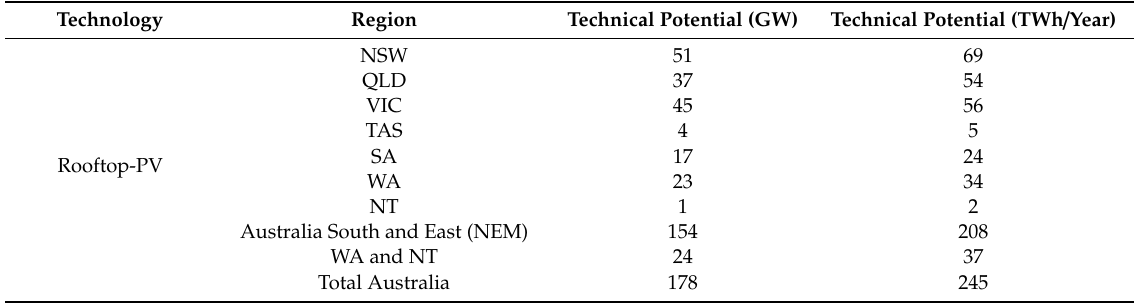
Table A10. Maximum installable capacity and generated electricity for roof-top PV in model regions according to the available potential. Data based on Reference